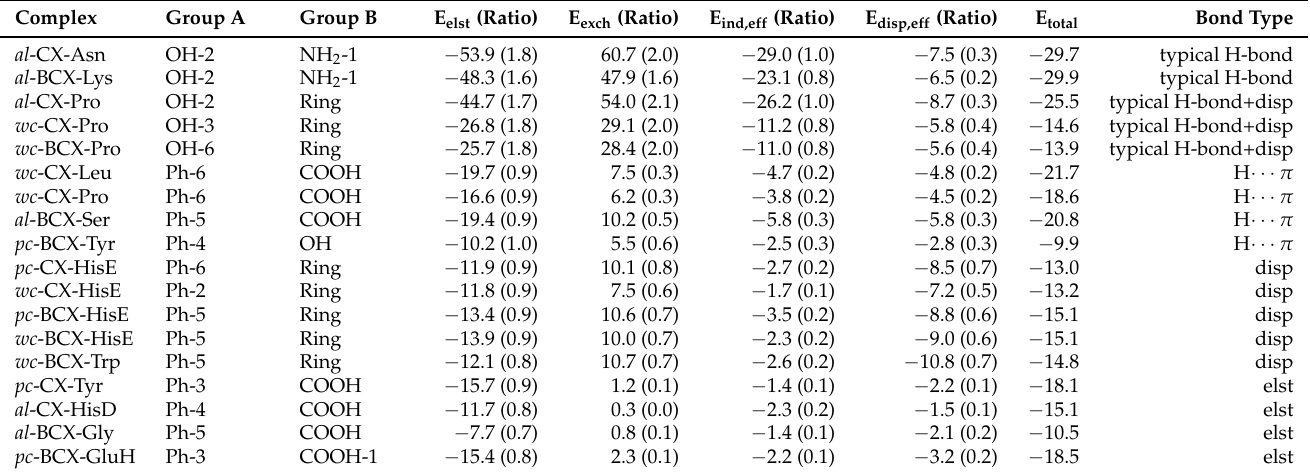
Table 5. The F-SAPT partitioning for selected pairs. Energies are in millihartree. The numbers in parenthesis are ratios with respect to total interaction energies between pairs, as defined in Section